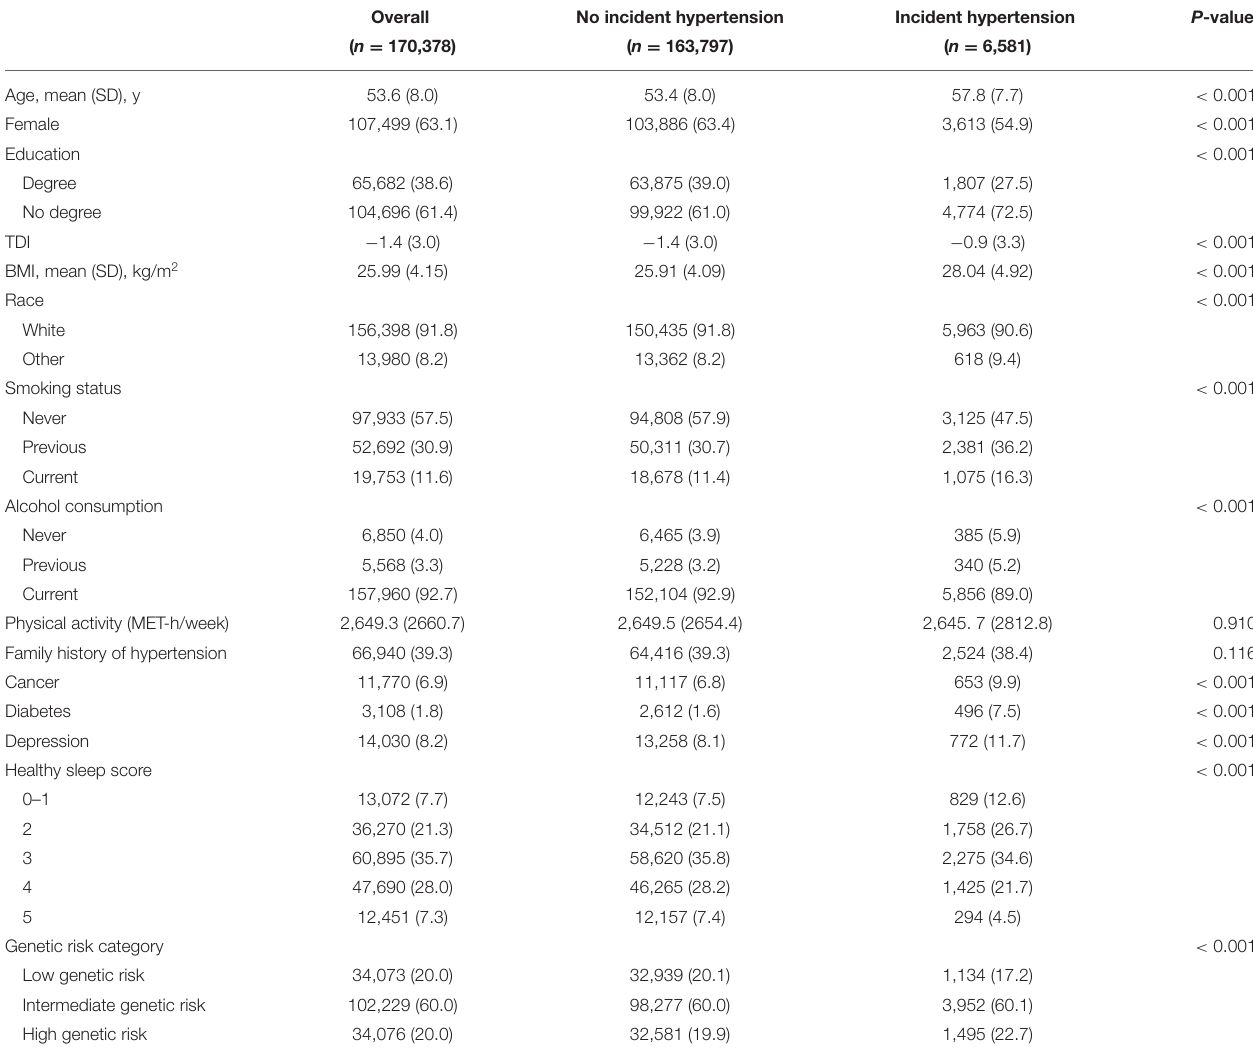
TABLE 1 | Baseline characteristics of